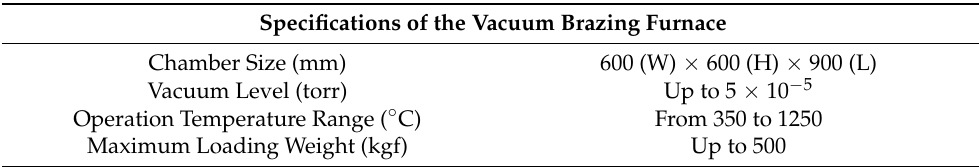
Table 2. Technical specifications of the vacuum brazing furnace.